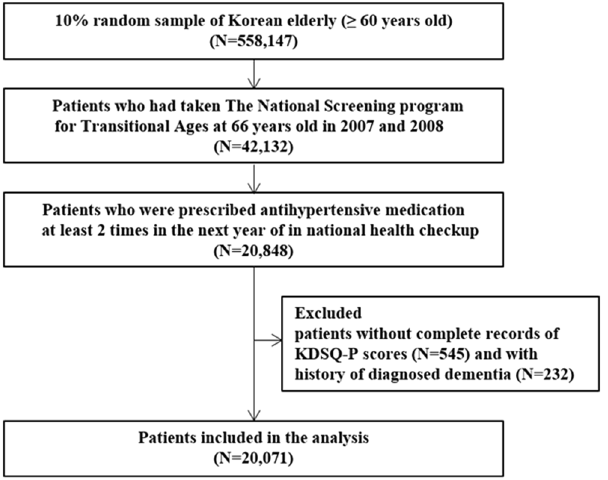
Figure 1. Study population. KDSQ-P, Prescreening Korean Dementia Screening